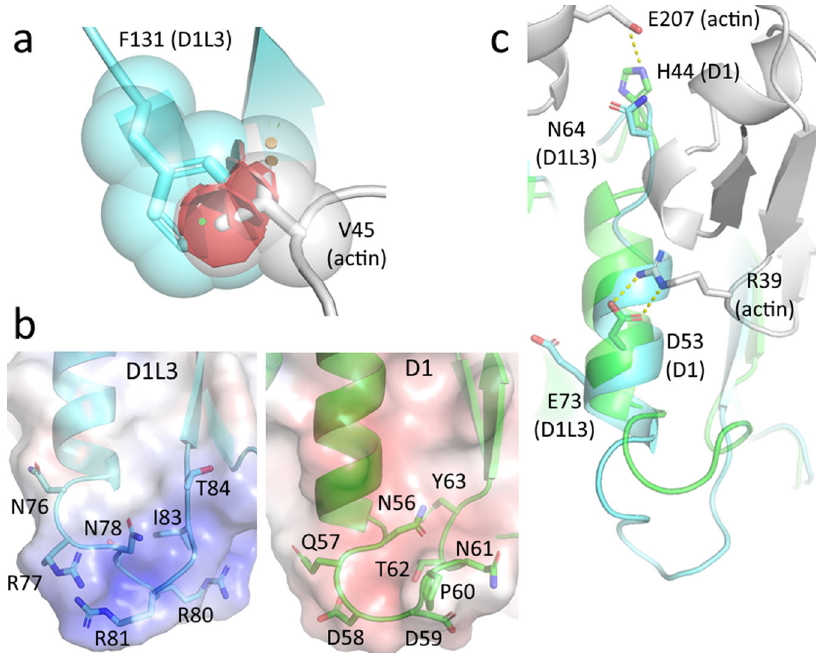
Fig. 1 Dnase1L3 inhibits actin binding. a Phe-131 of Dnase1L3 (blue) clashes (in red) with Val-45 of actin (grey) when actin is docked to Dnase1L3 24 . b Dnase1 (D1, green) is acidic (pI = 3.45) at the actin interface, whereas Dnase1L3 (D1L3, blue) is basic (pI = 11.15) at the homologous site. c The salt bridge interactions from Dnase1 (green) to actin (grey) are disrupted in Dnase1L3 due to the homologous α -helix (residues 67 – 75) from Dnase1L3 (blue) being out of register relative to the Dnase1 actin-binding α